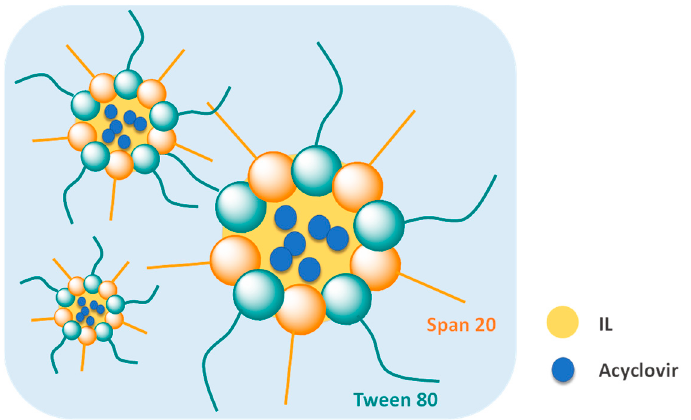
Figure 19. IL-in-oil microemulsions based on [C 1 C 1 im][(MeO) 2 PO 2 ] as drug carriers of acyclovir proposed in [198].